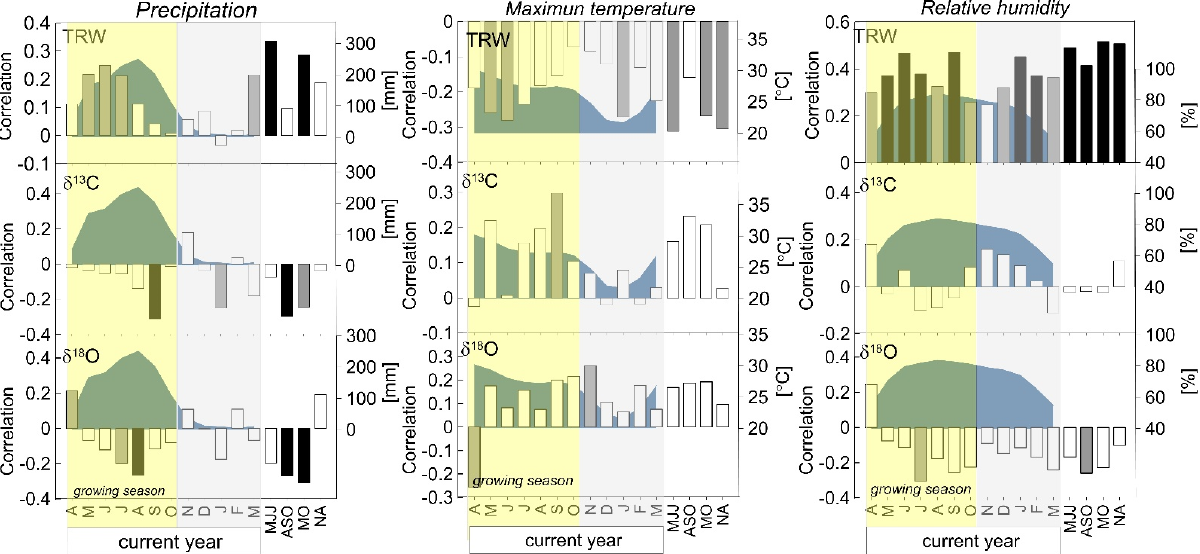
Figure 5. Correlation between the tree-ring chronology (TRW) ( top panel ), tree-ring δ 13 C chronology ( middle ) and tree-ring δ 18 O chronology ( lower panel ) with MHS meteorological station data (precipitation, maximum temperature and relative humidity). The black bars indicate significance at p < 0.01 , the gray bars are significant at p < 0.05 , and the white bar graph indicates non-significant correlation values. The yellow frame highlights the growing season. The blue areas indicate the values of precipitation (mm), maximum temperature ( ◦ C), or relative humidity (%) in the different